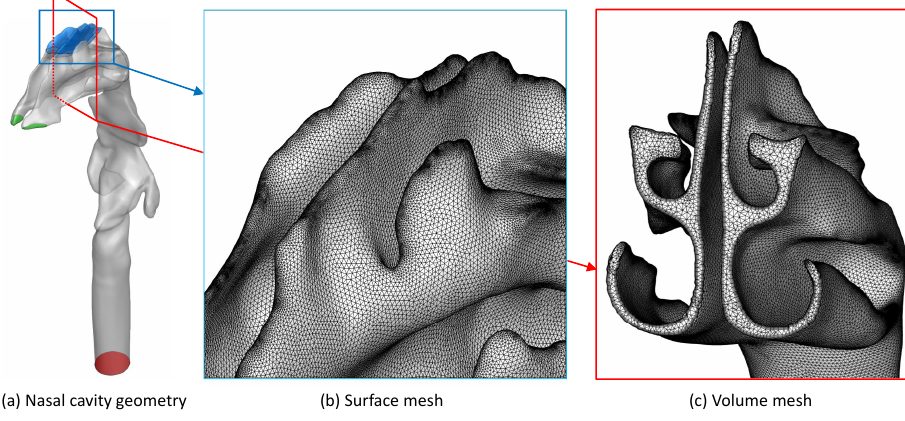
Figure 1. Details of the nasal airway model: ( a ) Geometry, ( b ) Surface mesh, and ( c ) Volume